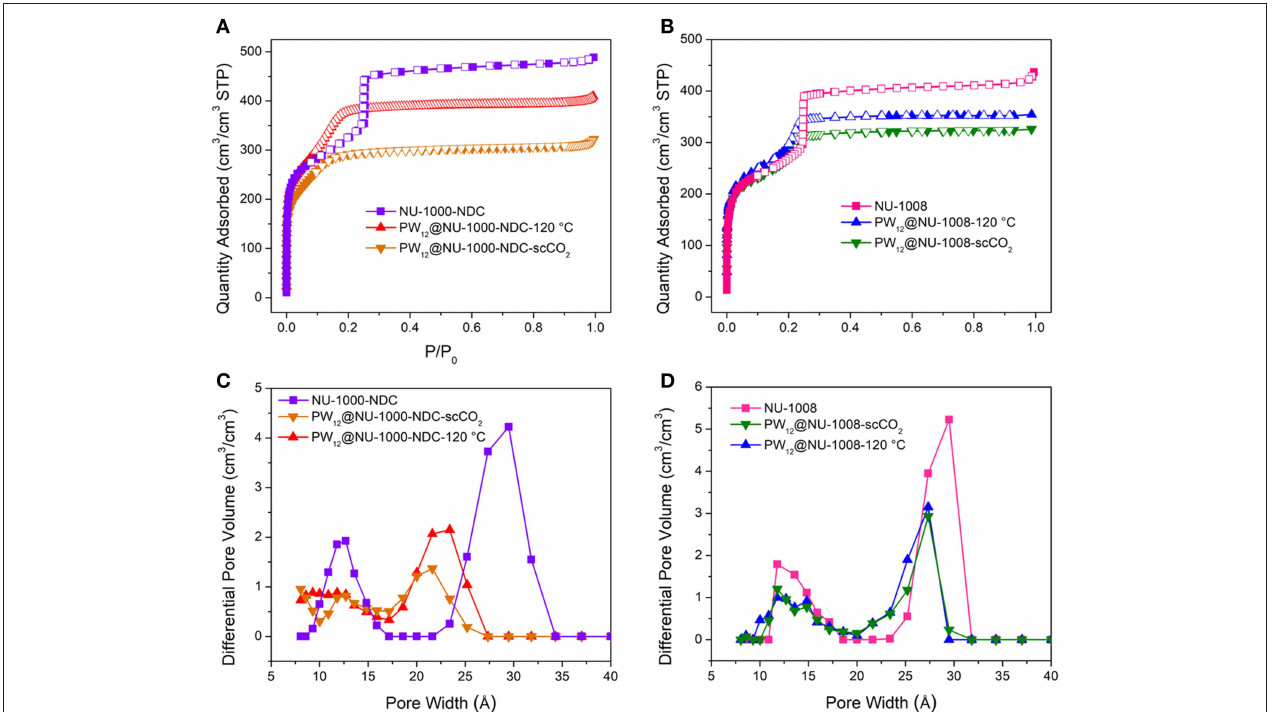
FIGURE 3 | N 2 sorption isotherms of (A) NU-1000-NDC with and without POM and (B) NU-1008 with and without POM. Corresponding DFT-calculated PSD of (C) NU-1000-NDC and its composites and (D) NU-1008 and its composites.